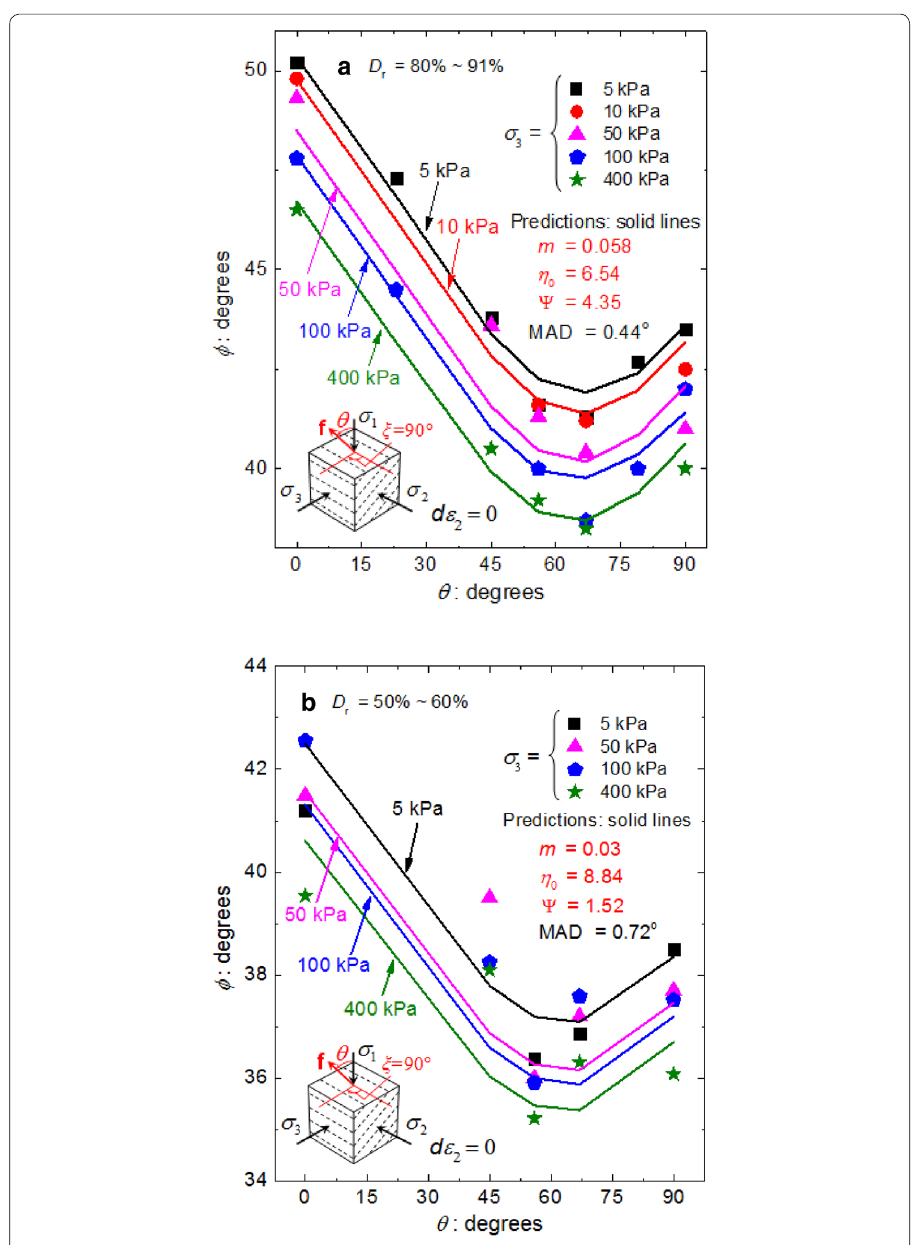
Fig. 16 Comparison between plane strain compression test results of Toyoura sand by Tatsuoka et al. [13] and predictions by this